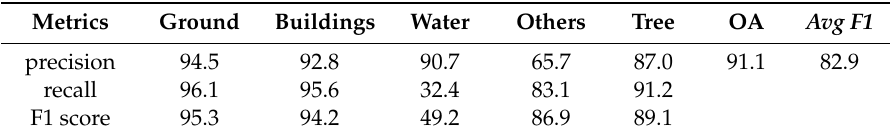
Table 1. Performance of classification results of our model with optimization using DFC 3D dataset. We report the precision, recall, and F1 score for each category in the first 3 columns as well as the OA and Avg F1 in the last two columns (All values are in %).